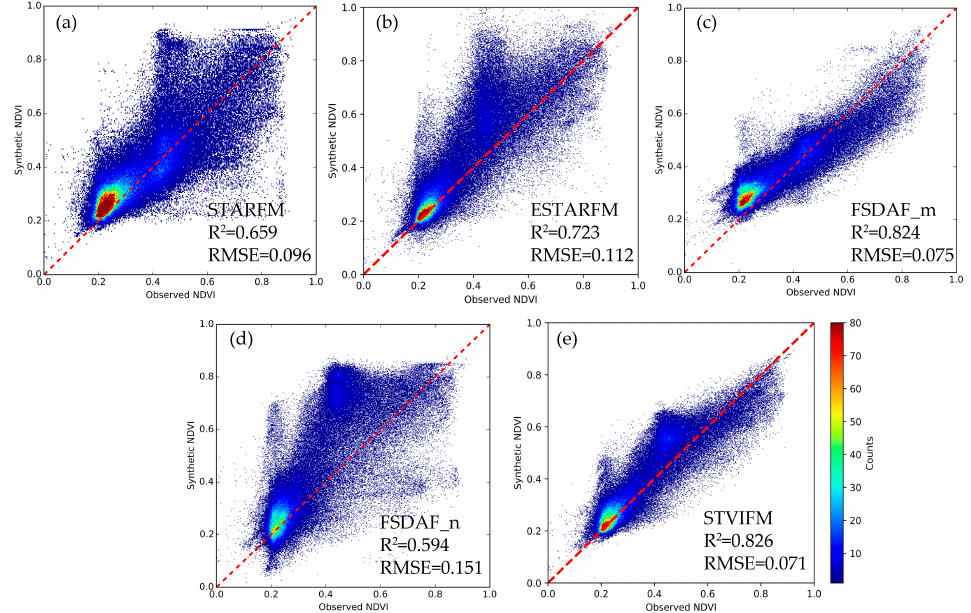
Figure 10. Scatter plots of the observed and synthetic Landsat NDVI produced by: STARFM ( a ); ESTARFM ( b ); FSDAF_m ( c ); FSDAF_n ( d ); and STVIFM ( e ) in Ontario, Canada.